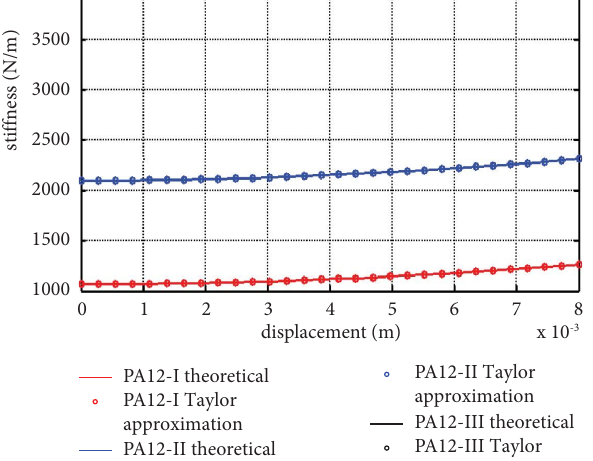
Figure 7: Restoring force of BQZSS. Table 3: Coefcients of Taylor approximation.